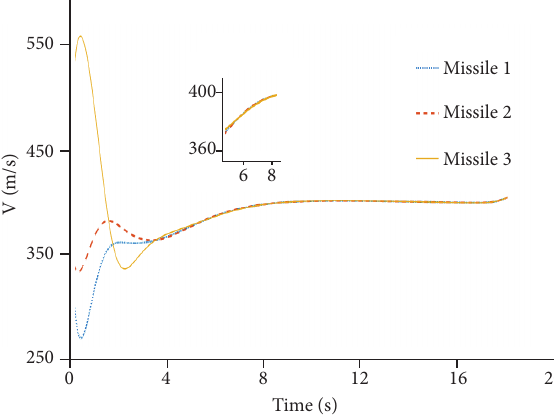
Figure 4. Velocity curves of the following interceptors obtained using the improved cooperative control strategy.